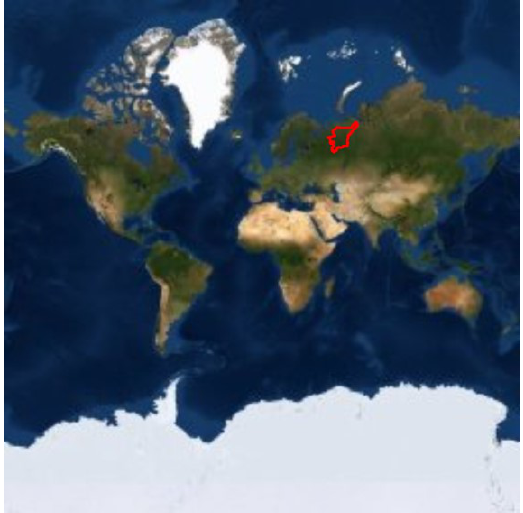
Figure 1. Location of the study area; Republic of Komi is marked by red contour; satellite imagery courtesy of the ESRI ArcGIS